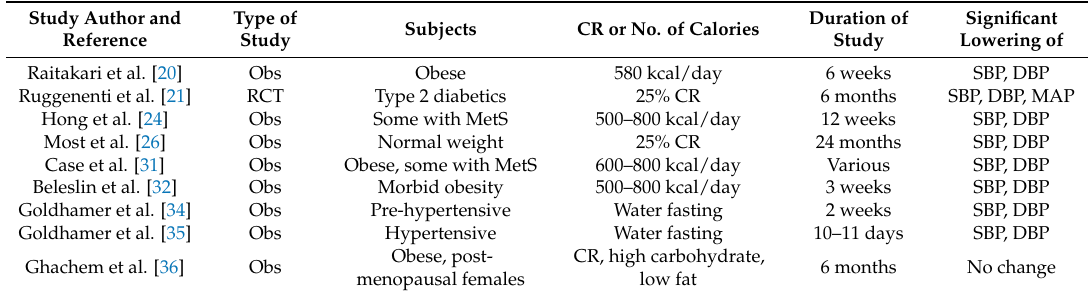
Table 1. Summary of studies showing the effect of fasting or caloric restriction on blood pressure in >50 human